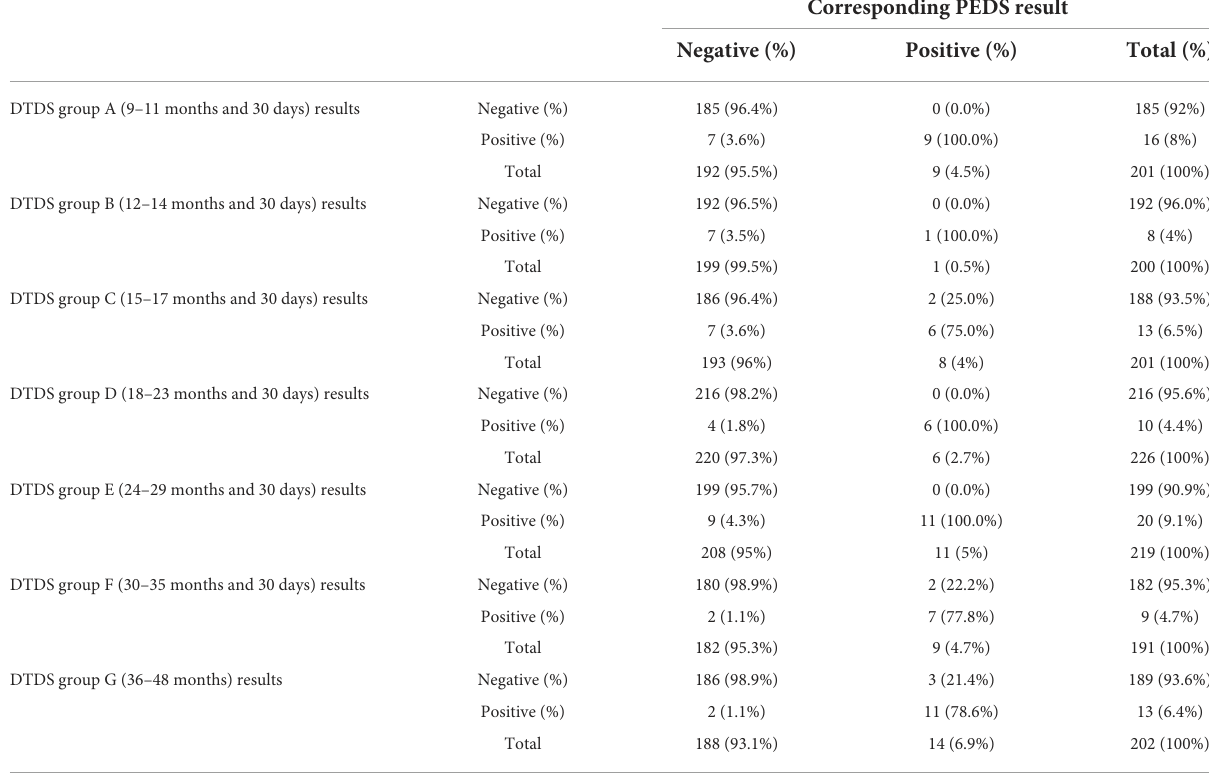
Corresponding PEDS result